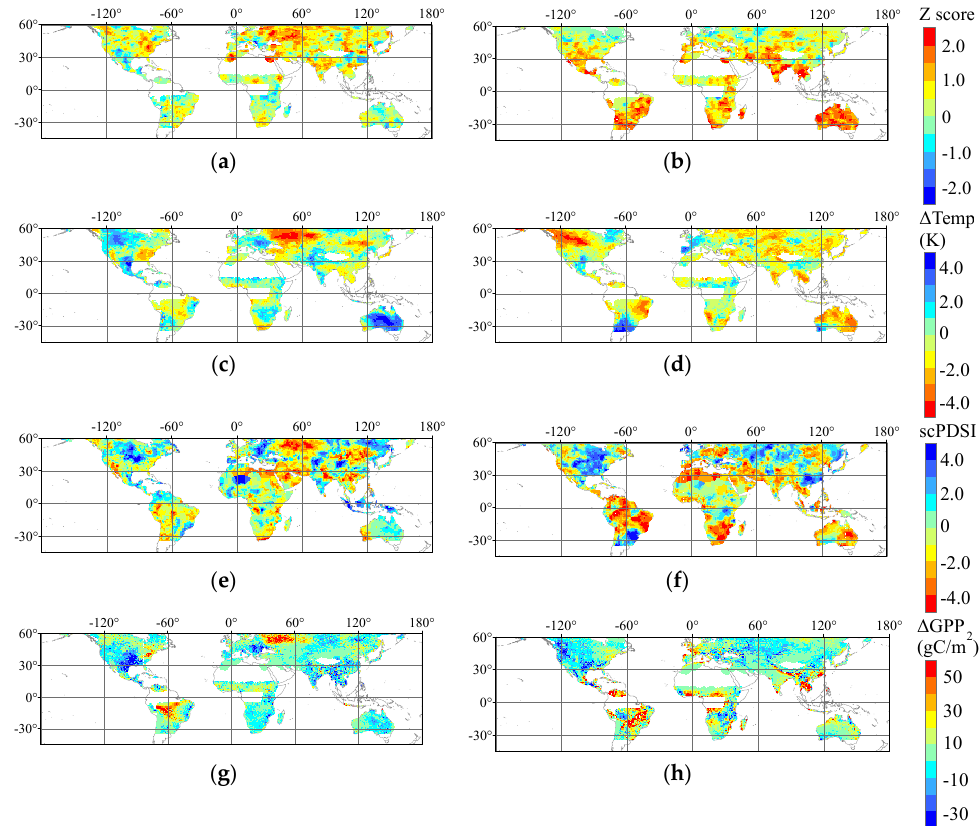
Figure 9. Spatial distribution of the Z score of GM ‐ XCO 2 fitting residuals (dXCO 2 ) (an important criteria for extreme detection) during July–September of 2010 and March–May of 2016 (extremely high value of anomaly XCO 2 grids) are shown in ( a , b ). Positive (red) values represent high possibility of being high XCO 2 and verse vice. And corresponding value of differences between observation and normal state in surface skin temperature ( Δ Temp (K)), gross primary production ( Δ GPP (gC/m 2 )) are shown in ( c , d , g , h ). Positive (red) values indicate high temperature and low GPP, and versa vice. Self ‐ calibrating Palmer Drought Severity Index (scPDSI) are shown in ( e , f ). Negative (red) value indicates drought, and versa vice. ( a ) Z score of GOSAT dXCO 2 in July–September 2010; ( b ) Z score of GOSAT dXCO 2 in March–May 2016; ( c ) mean increased Temp. in July–September 2010; ( d ) mean increased Temp in March–May 2016; ( e ) mean scPDSI in July–September in 2010; ( f ) mean scPDSI in March– May in 2016; ( g ) mean reduced GPP in July–September in 2010; ( h ) mean reduced GPP in March–May in 2016.